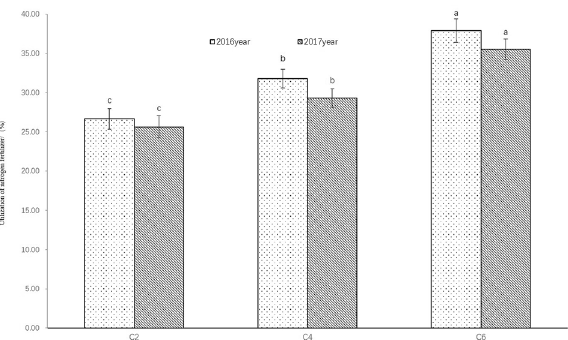
Figure 7. Nitrogen fertilizer utilization under different irrigation in 2016 and 2017. Different lowercase letters in the same column indicate significant differences ( p < 0.05) among different treatments in the same year.